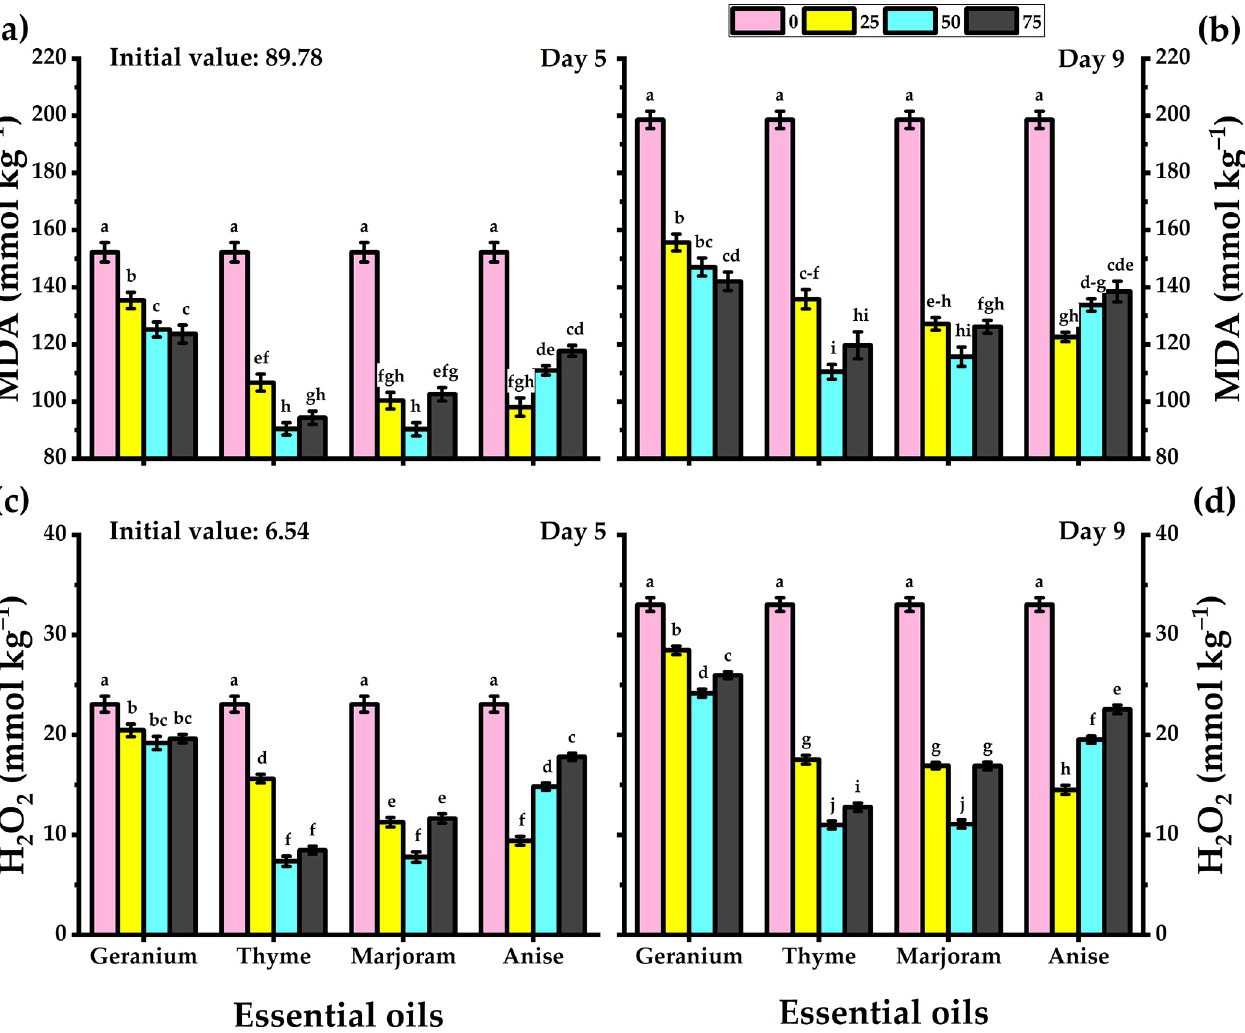
Fig 6. Response of carnation cut flowers to geranium, thyme, marjoram, and anise essential oils at 0, 25, 50, and 75 mg/L concentrations as preservative solutions on the MDA (a,b), and H 2 O 2 at day 5 and day 9 of vase life period. Bars with the same letters are not significantly differed at p � 0.05 level.